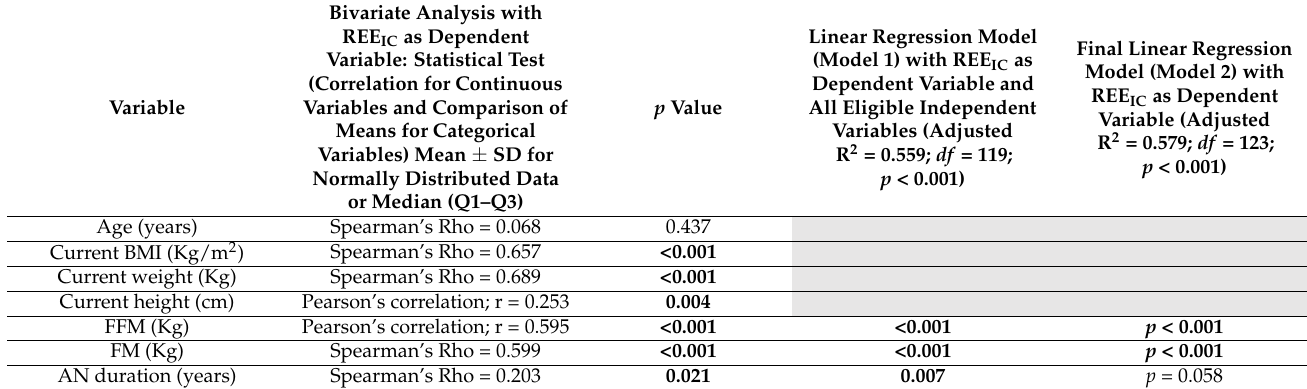
Table 2. Bivariate analysis and multivariate analysis of variables associated with REE